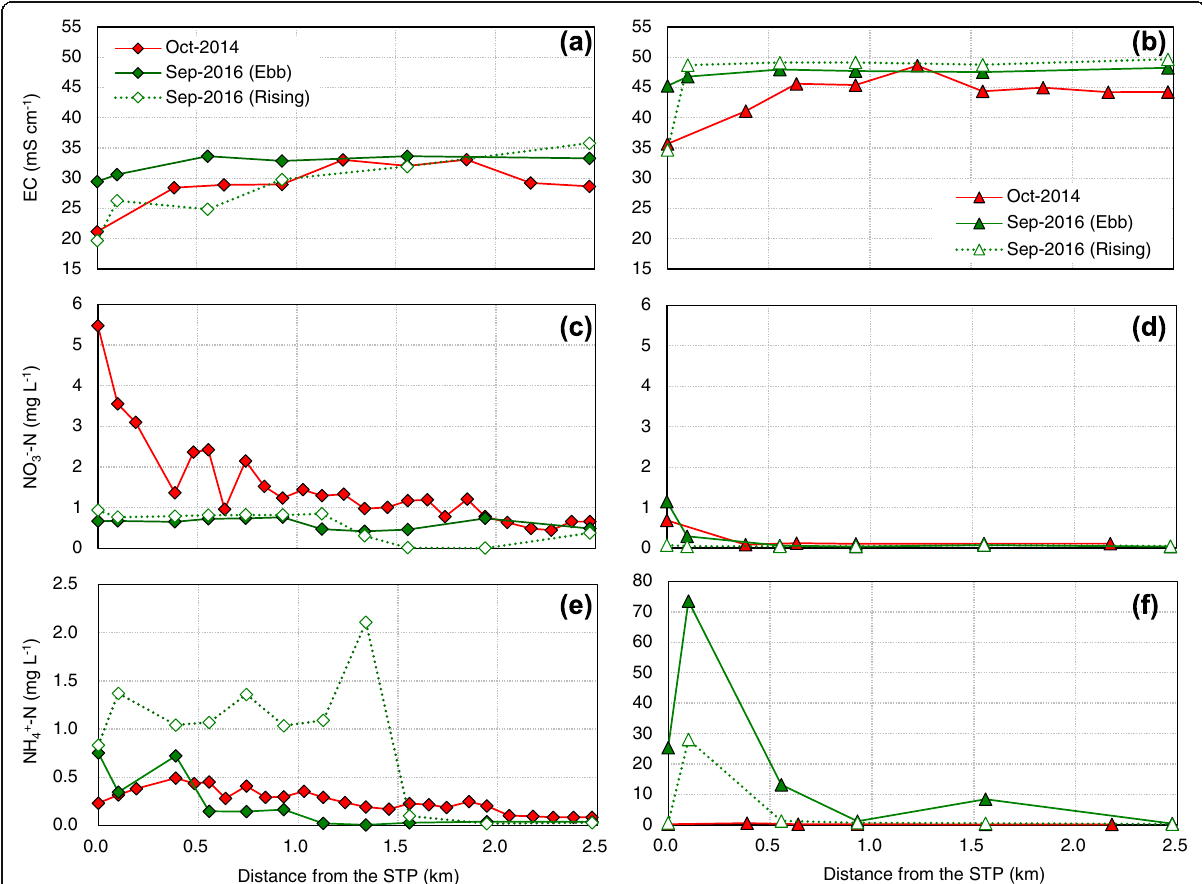
Fig. 5 Spatial variation of a , b EC, c , d NO 3 − -N, and e , f NH 4+ -N in the surface ( a , c , e ) and bottom ( b , d , f ) seawater of the KH line in October